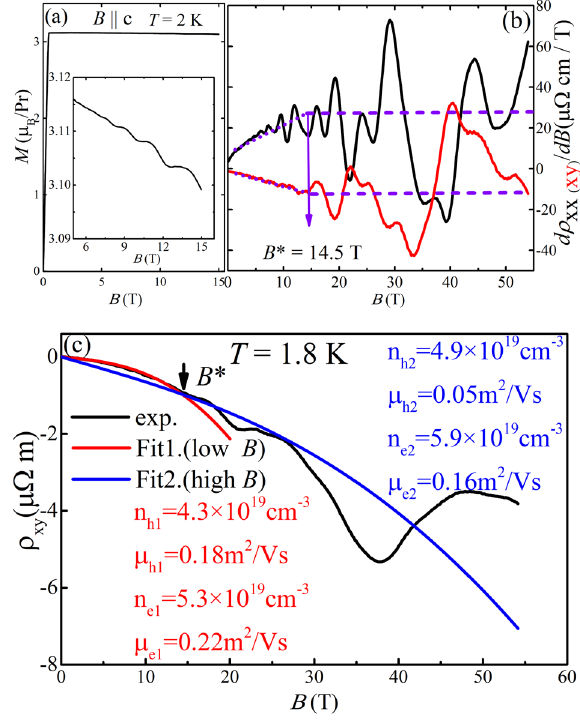
Fig. 4 Evolution of the density of carriers with the LT. a The magnetization of PrAlSi with the magnetic fi eld applied along the c - axis, the inset is the enlarged part with evident QOs. b The black and red lines are the fi rst derivative of the MR and Hall resistivities measured under a pulsed fi eld which could provide more information beyond the critical fi eld. The violet dotted lines guided by eyes suggest the change of slopes in both of them at the B * . c The fi eld dependence of Hall resistance at 1.8 K along with two fi tting curves with the two-band model. The red and blue curves correspond to the fi ts to the low- fi eld and high- fi eld,